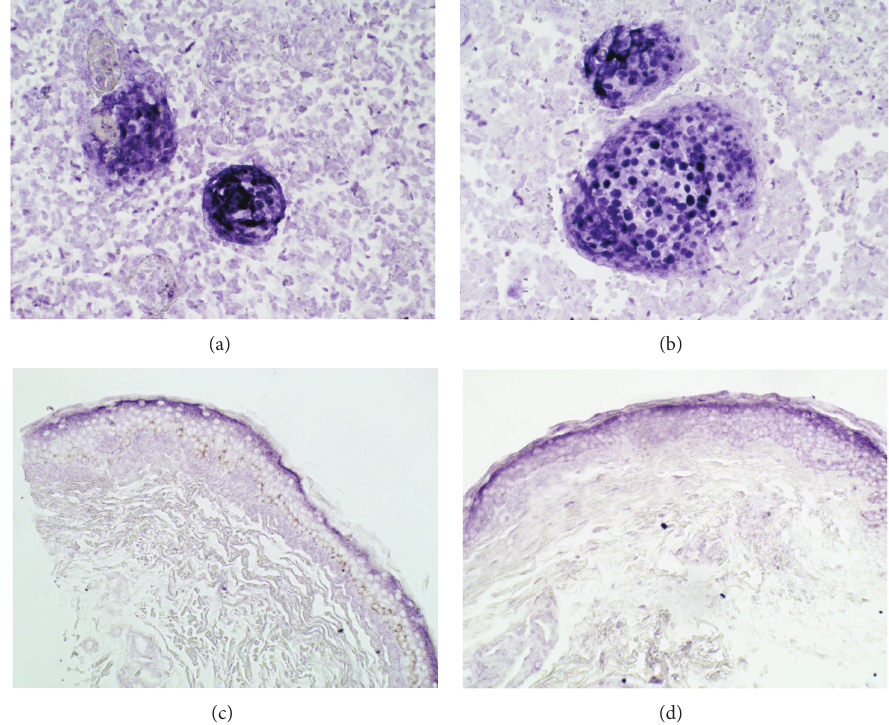
Figure 4: In situ hybridization (ISH) confirms that miR-182 is localized to MCC tumor cells. Panels (a) and (b) demonstrate that miR-182 is highly expressed in MCC cells versus the surrounding tissue in a sample of MCC of the cheek; original magnification × 200. Panels (c) and (d) demonstrate that miR-182 expression is low compared to that in MCC cells in a sample of normal skin; original magnification ×